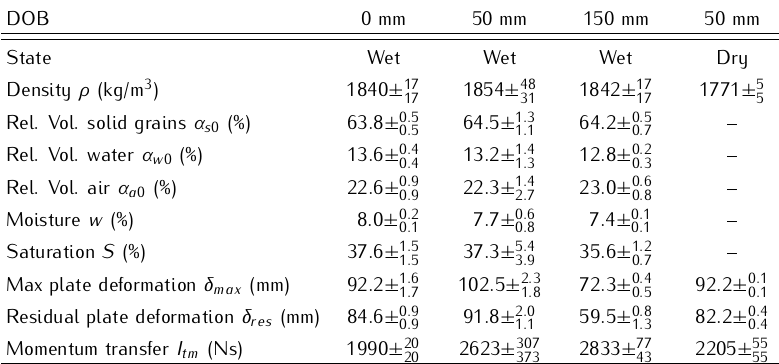
Table 2. Initial conditions for the soil along with test results